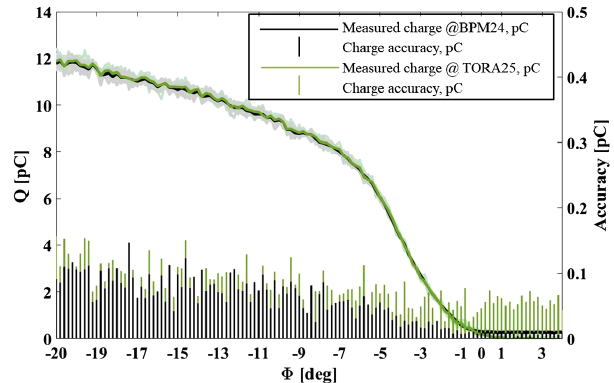
FIG. 5. Zero-crossing phase determination. The shading curves represent 10 individual measurements using a beam position monitor and a toroid monitor, respectively. The black and green curves show the averaged data.